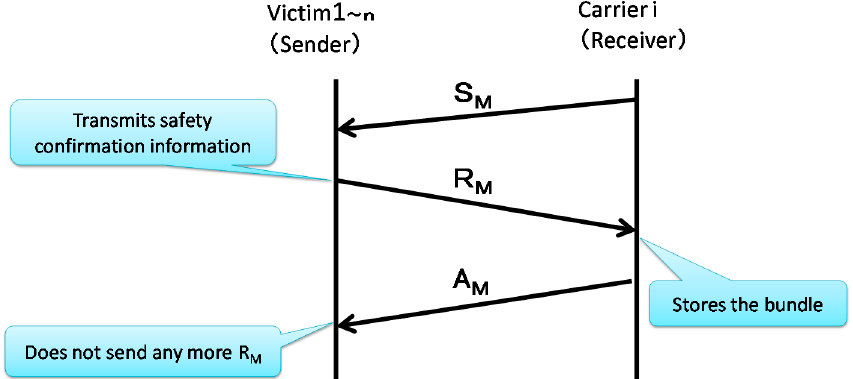
Figure 4. Sequence of communication between a victim terminal and a carrier